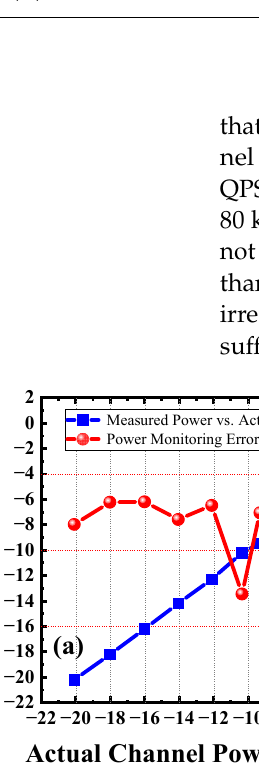
Figure 11. Results of channel power monitoring and monitoring error ( a ) in QPSK system, and ( b ) in 16QAM system.